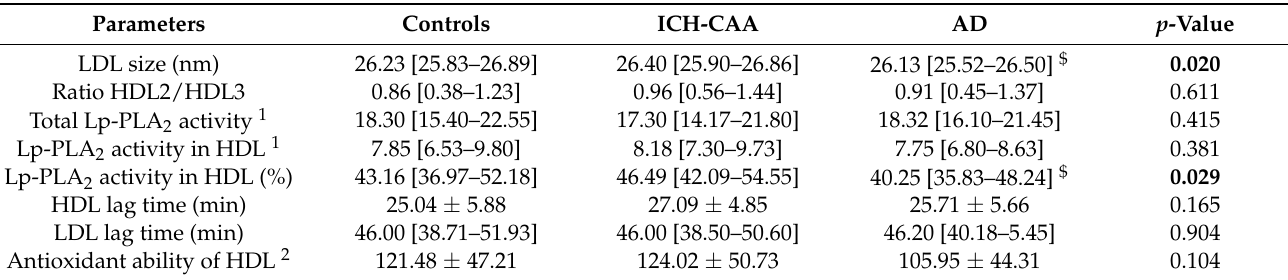
Table 7. Lipoprotein size, Lp-PLA 2 activity and oxidative properties of LDL and